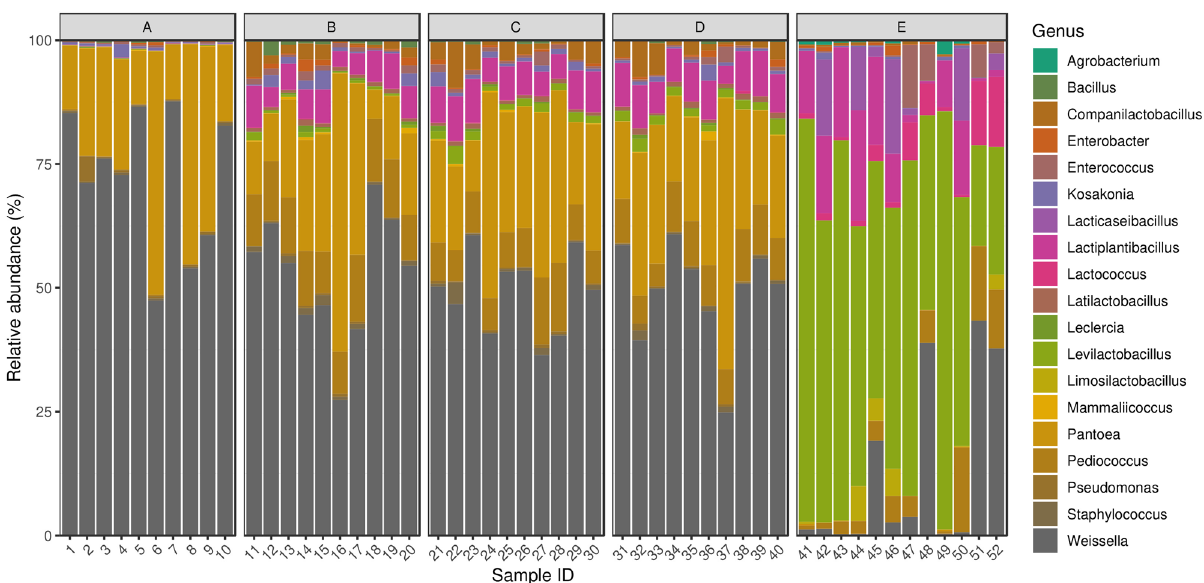
Figure 1. Silage core bacteriome. Relative abundances of genera that achieved more than 1% of the bacterial hits in any of the samples. The elements of the PRJNA495415 dataset were taken on days 0, 7, 14 and 28 were classified into groups A, B, C and D, respectively. All items from BioProject PRJNA764355 are assigned to group